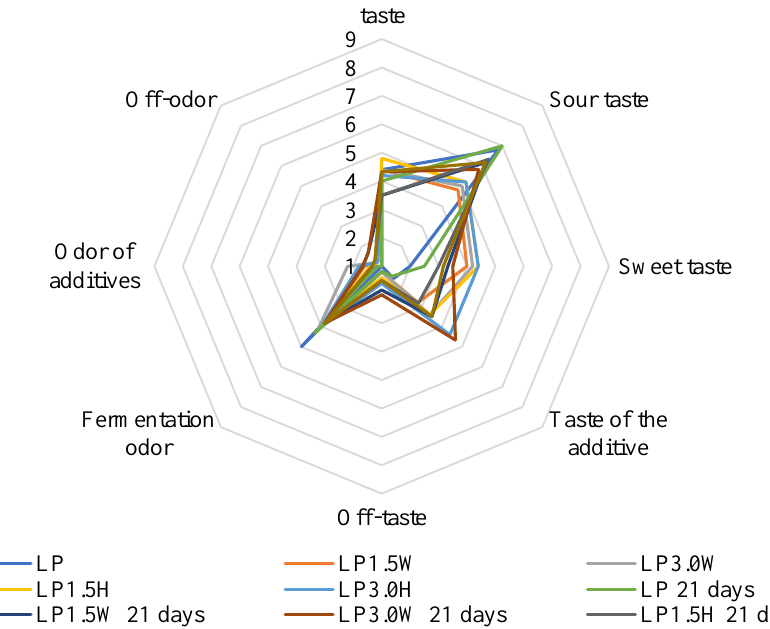
Figure 3. Effect of collagen addition on the organoleptic parameters of milk fermented by L. paracasei after 1 and 21 days of cold storage. LP — control milk with Lacticaseibacillus paracasei; LP1.5W — milk with 1.5% collagen and Lacticaseibacillus paracasei; LP3.0W — milk with 3.0% collagen and Lactica- seibacillus paracasei ; LP1.5H — milk with 1.5% collagen hydrolysate and Lacticaseibacillus paracasei ; LP3.0H — milk with 3.0% collagen hydrolysate and Lacticaseibacillus paracasei.